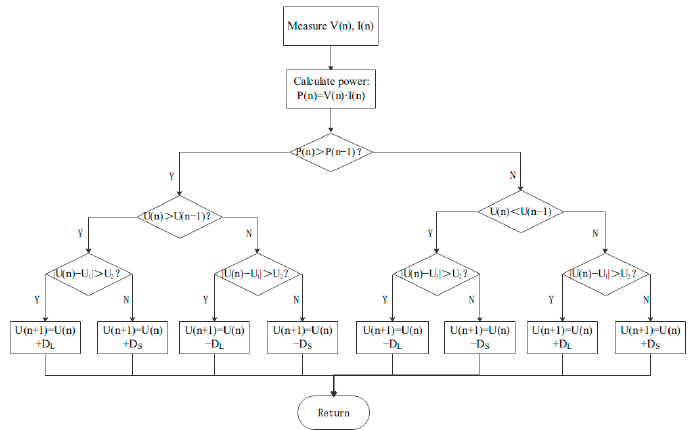
Figure 14. Flowchart of the improved P&O MPPT.